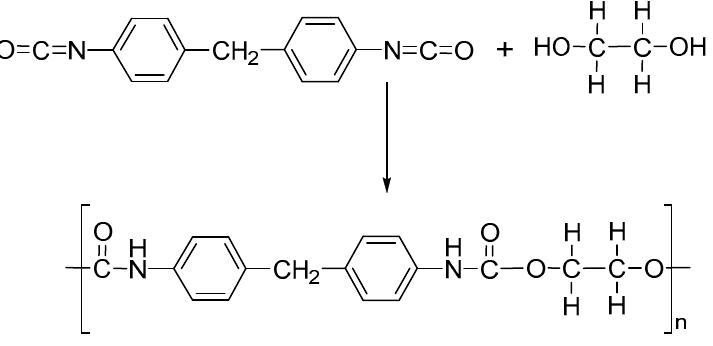
Figure 11. Synthesis of polyurethane.